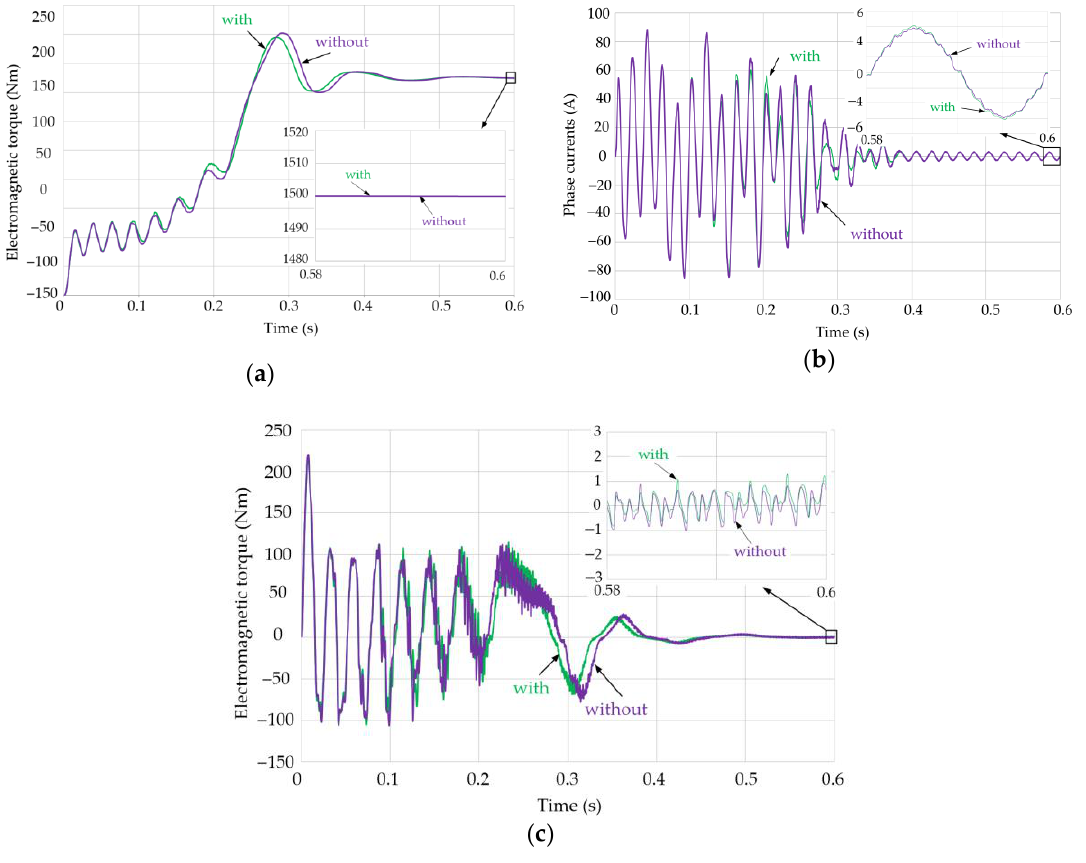
Figure 14. Time curves: ( a ) rotor speed n ( t ), ( b ) phase current i 1 ( t ) and ( c ) electromagnetic torque T e ( t ) during start-up at T L = 0 Nm, J i = 0.041 kgm 2 , τ i = 26 ° C.